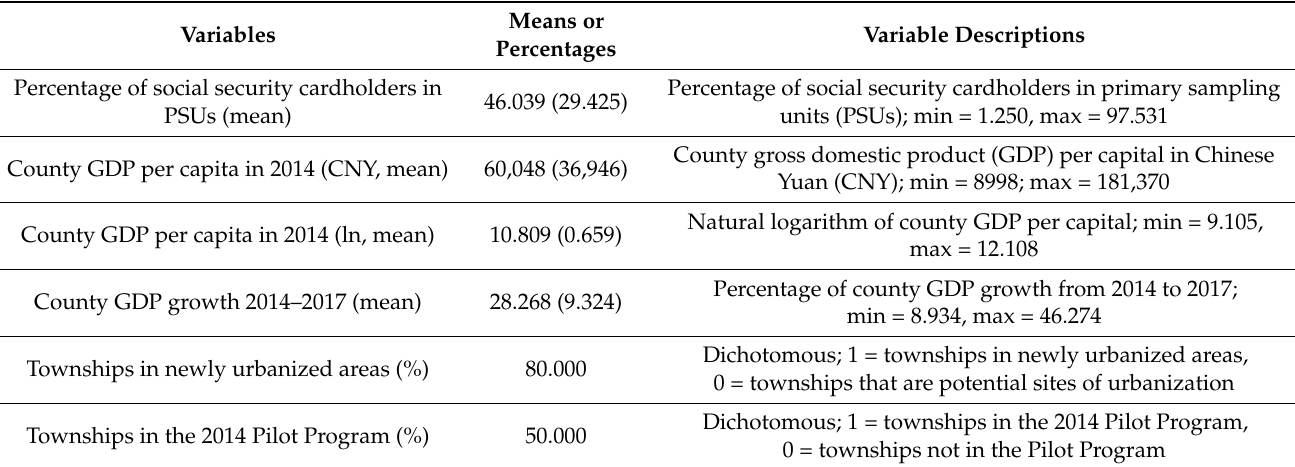
Table 2. Descriptive statistics of county/township-level variables.